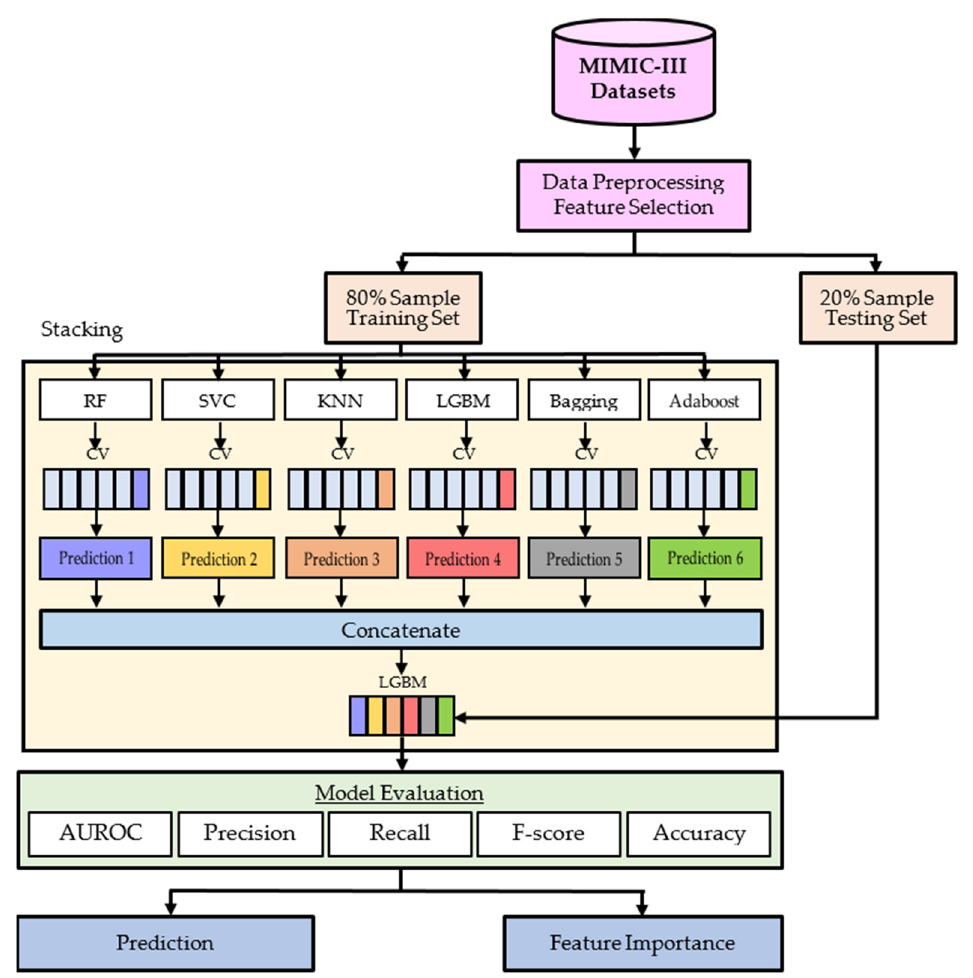
Figure 2. Stacking ensemble based on a cross-validation of all feature subsets.